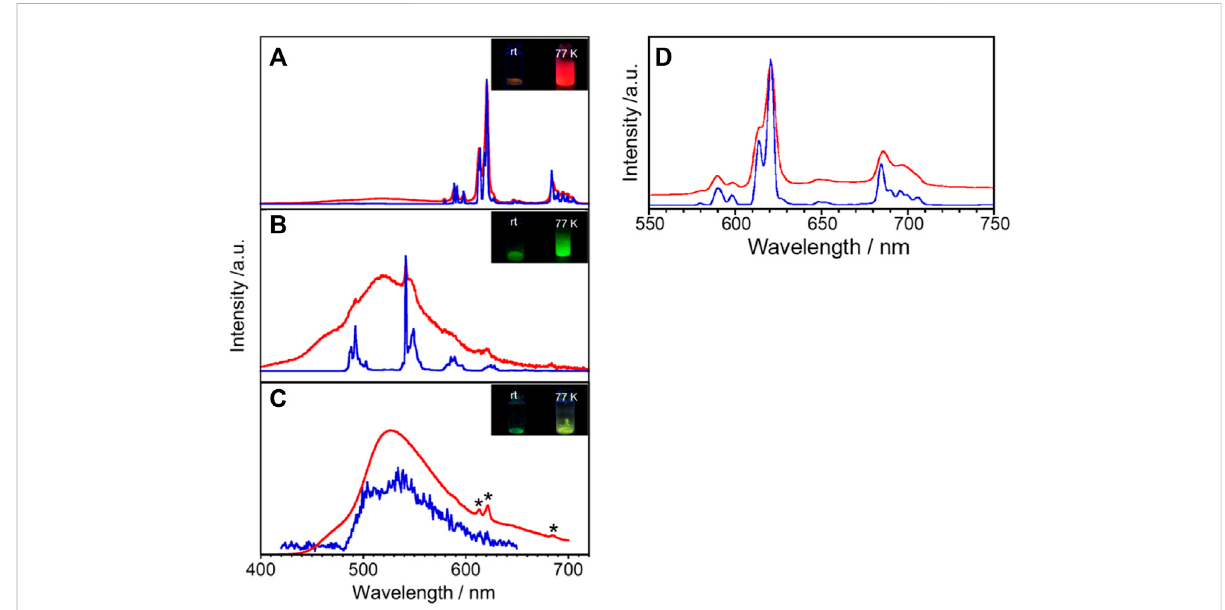
FIGURE 3 Temperaturedependenceofthesolid-stateluminescence spectra of (A) Eu L , (B) Tb L , and (C) Gd L atrt (red) and77 K(blue). λ ex =380 nm,*due to impurity. Inset in (A) , (B) , and (C) : photograph of luminescence of Eu L , Tb L , and Gd L , respectively, at various temperatures. (D) Eu L also shows a luminescence band at λ ex = 400 nm.